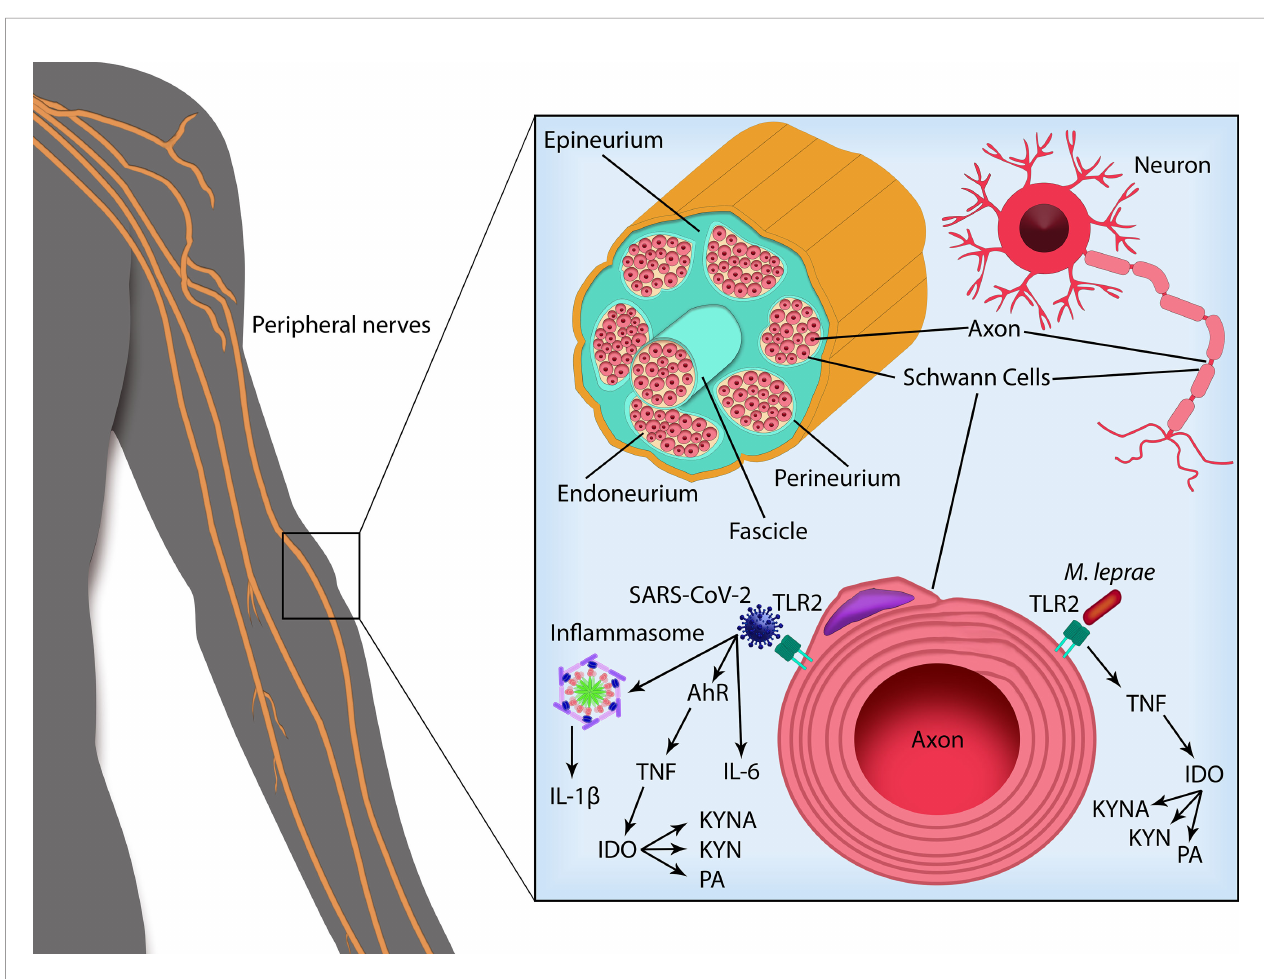
FIGURE 2 | SARS-CoV-2 and Mycobacterium leprae infection in peripheral nerve Schwann cells. Peripheral nerves are composed offascicles delimited by the perineurium and enveloped by the epineurium. Inside the nerve fascicles, surrounded by the endoneurium, the axons from each neuron are encircled by Schwann cells (SCs) that form the myelin sheath. SARS-CoV-2 infection activates the transcription factor aryl hydrocarbon receptor (AHR), leading to TNF production. SARS- CoV-2 can also bind TLRs triggering their activation and subsequent production of pro-in fl ammatory cytokines as IL-6 and IL-1 b , cleaved by caspase-1 following in fl ammasome activation. Recognition of M. leprae via TLRs in the SCs leads to the production of TNF. M. leprae infection in myelinating SCs can also induce apoptotic cell death by a mechanism dependent on TNF and TLR2, degradation of myelin sheath and peripheral nerve fi brosis. TNF (as well as IL-6 and IL-1 b ) activates the enzyme indoleamine 2,3-dioxygenase (IDO) that catabolizes tryptophan via kynurenine pathway. Formation of neuroactive metabolites of kynurenine (KYN) such as kynurenic acid (KYNA) and picolinic acid (PA) can contribute to nerve damage. SARS-CoV-2 and M. leprae co-infection may trigger a higher pro- in fl ammatory state leading to increased neuropathy and possibly triggering leprosy reactional